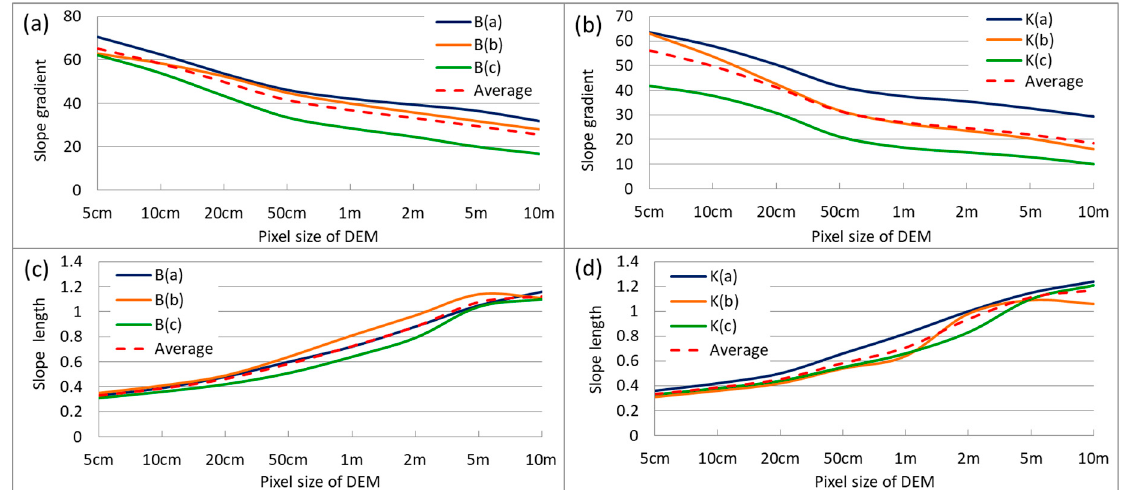
Figure 2. Variation of pattern of slope gradient ( a , b ) and slope length ( c , d ) of the selected plots at different digital elevation model (DEM) resolutions.